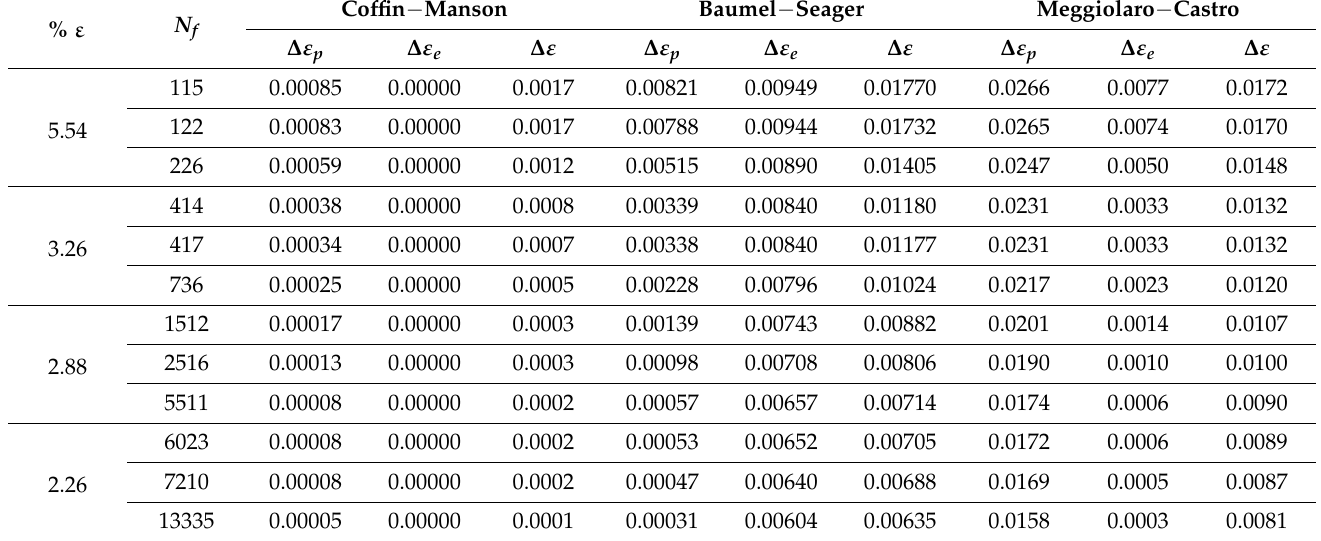
strain ( ∆ ε e and ∆ ε p , respectively) for the Coffin − Mason (CM) Equation (1), Baumel − Seager (BS) Equation (2), and Meggiolaro − Castro (MC) Equation (3) are presented in Table 4. Table 4. Measured cycles and strain for the fatigue tests and constants for the Coffin − Manson, Baumel − Seager, and Meggiolaro − Castro